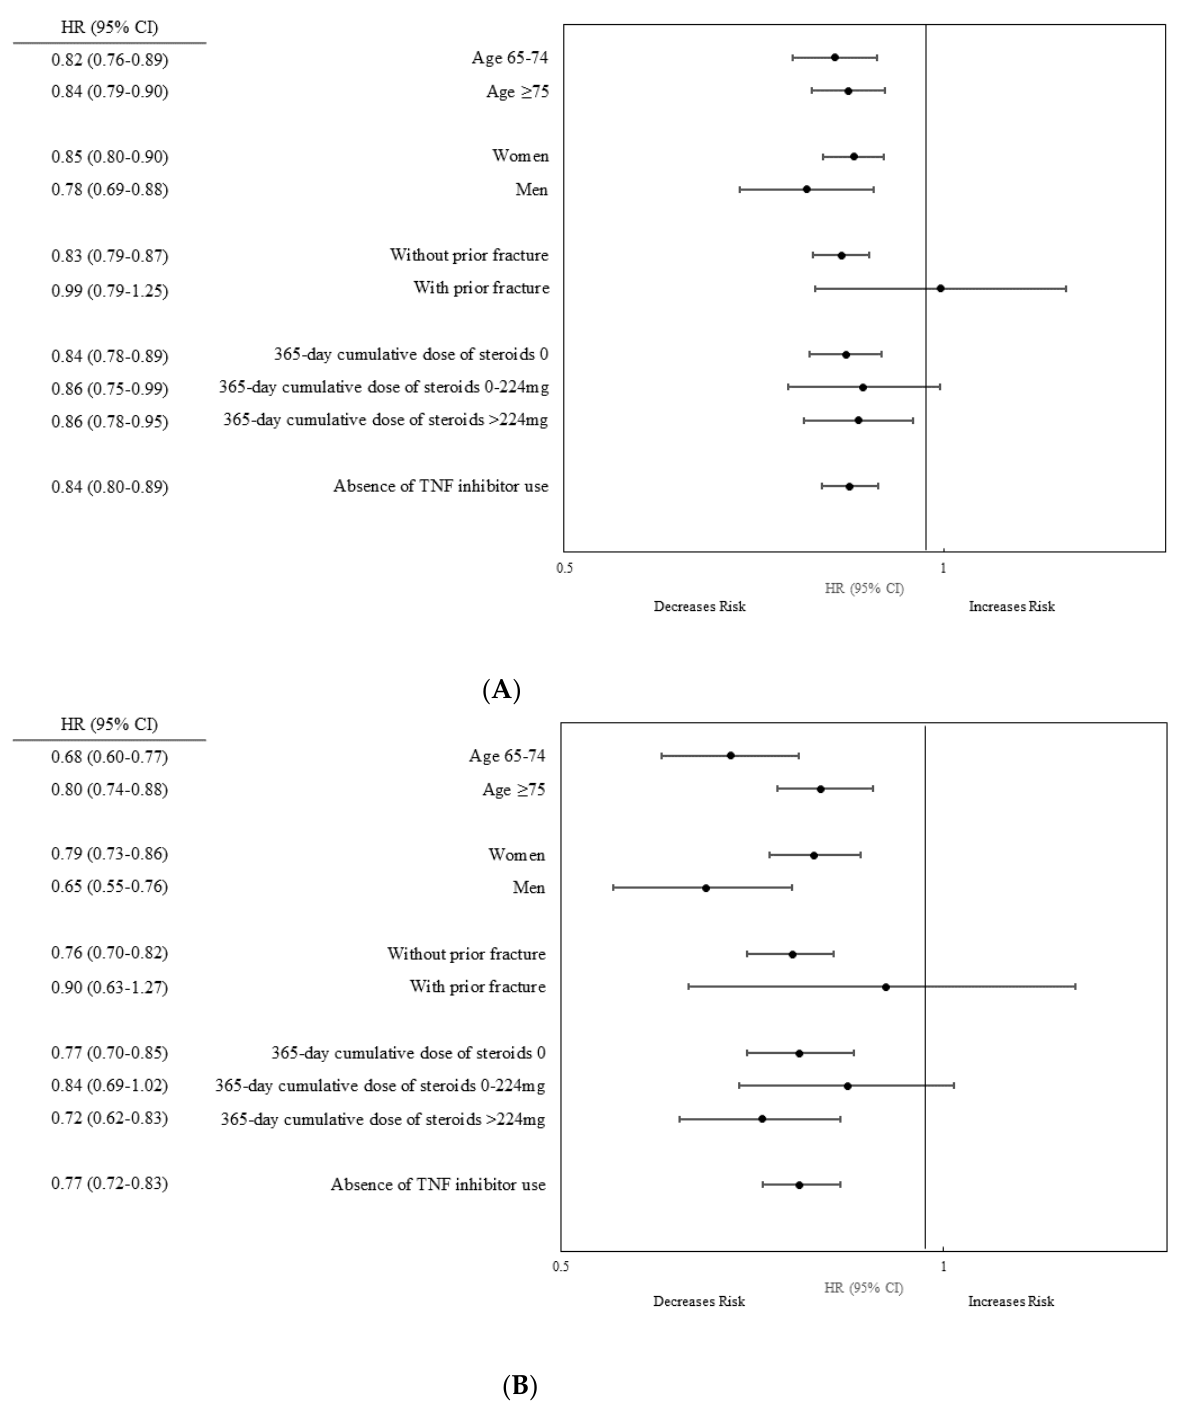
Figure 2. Stratified analysis: Multivariable hazard ratios of fracture in the gout group compared with the RA group ( A ). Non-vertebral fracture, ( B ). Hip fracture.